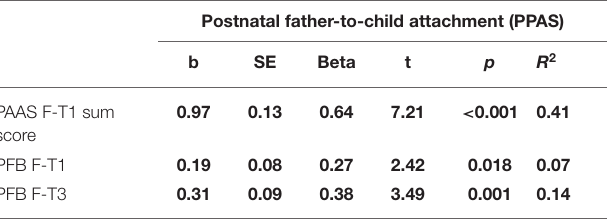
TABLE 5 | Univariate associations of antenatal attachment and partnership quality with postnatal father-to-child attachment. Postnatal father-to-child attachment